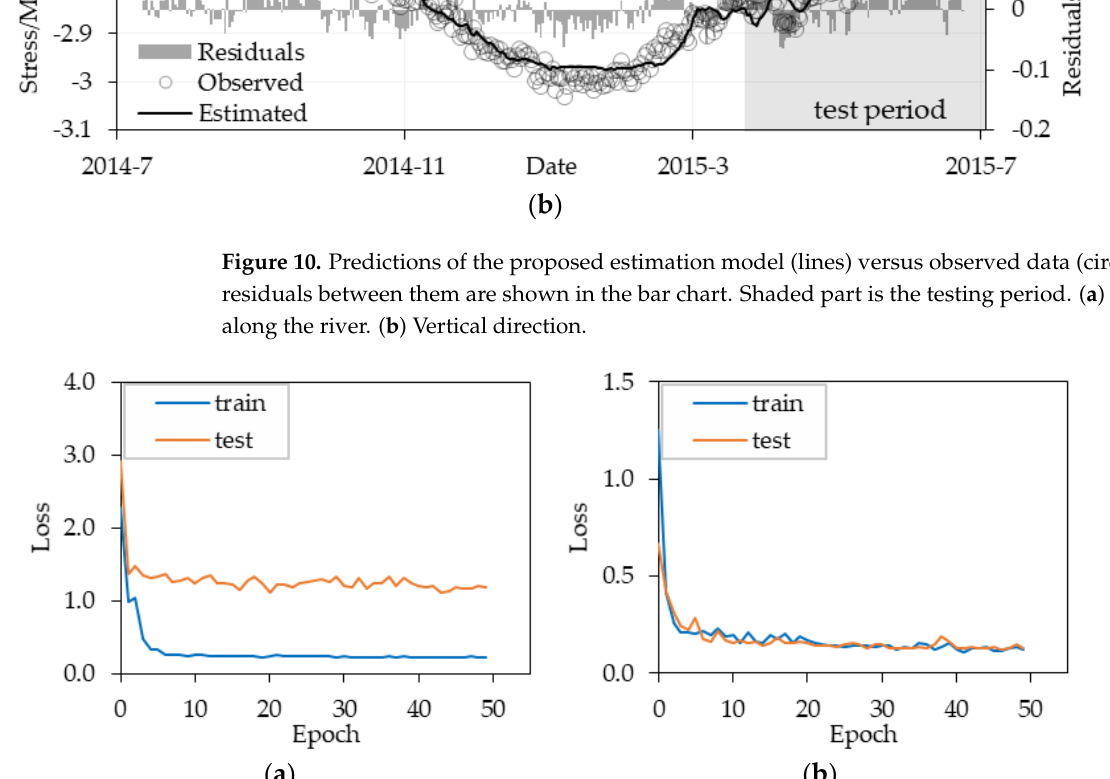
RMSE: root mean square error; MAPE: average absolute percentage error; ARV: average relative variance.